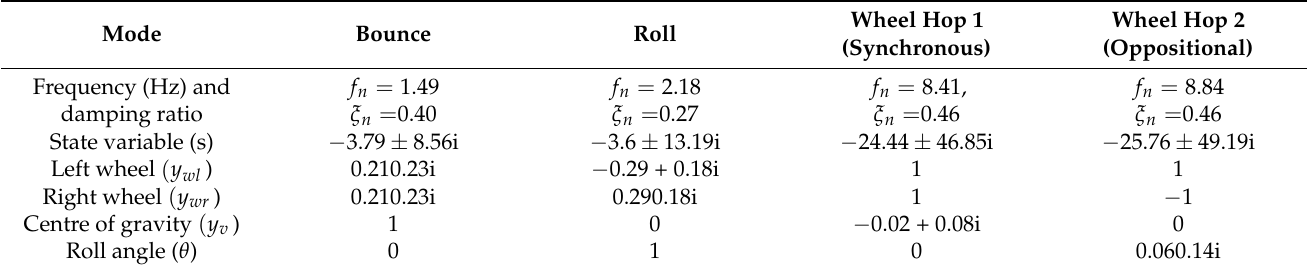
Table 3. Vibration modes of the HIIRS-equipped